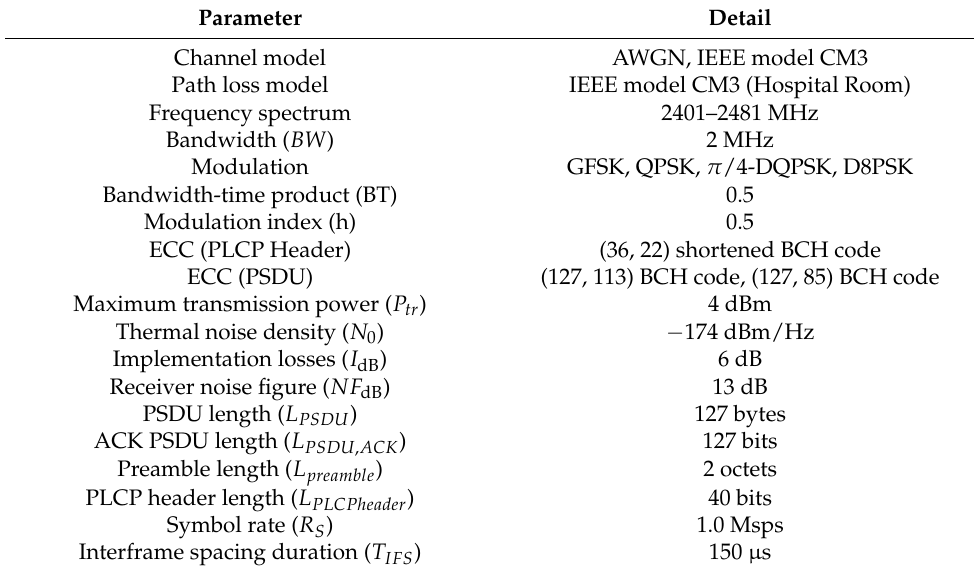
Table 5. Computer simulation parameters.